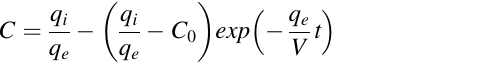
4 : 8 m 3 /min, which are obtained at both ends of the cosine curve respectively. The air leakage in the middle part is small in symmetry. There was no fresh air flowing into the fire zone from 13:00 pm to 19:00 pm. The gas inside part of the fire zone flows back from the return air side to the fire zone. The better the airtightness, the larger the wind resistance. When the wind resistance is 5 9 10 4 N s/m 5 , the